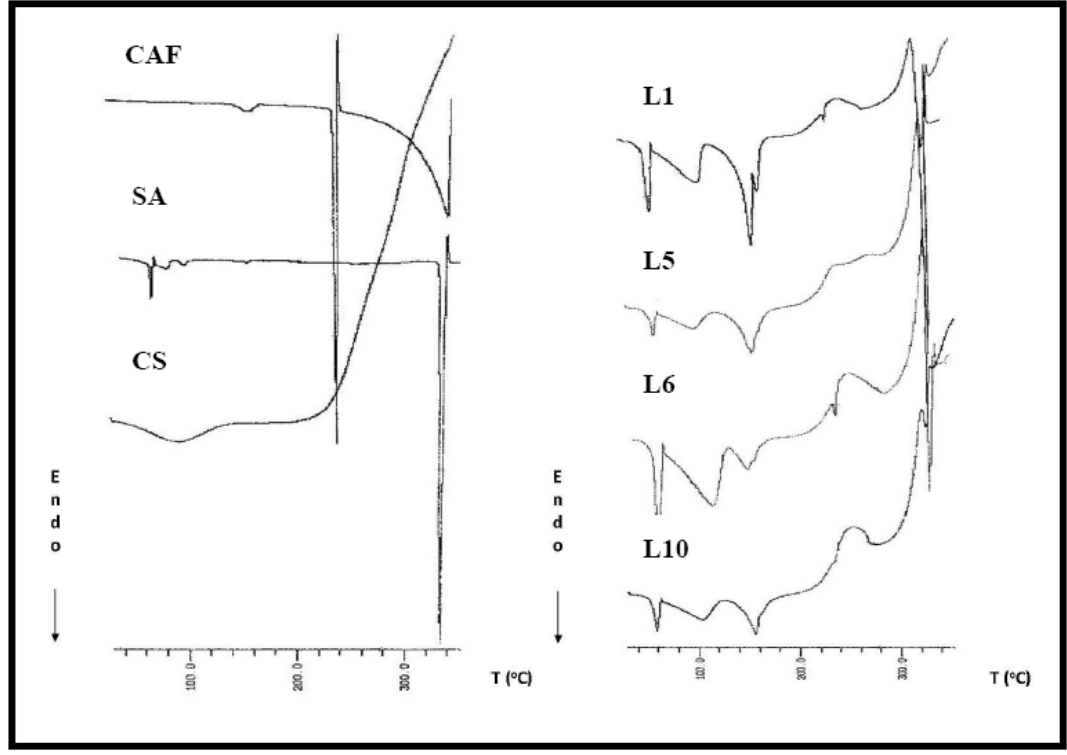
Figure 2. DSC curves of caffeine (CAF), chitosan (CS), sodium acetate (SA) and lyophilized formulations L1, L5, L6 and